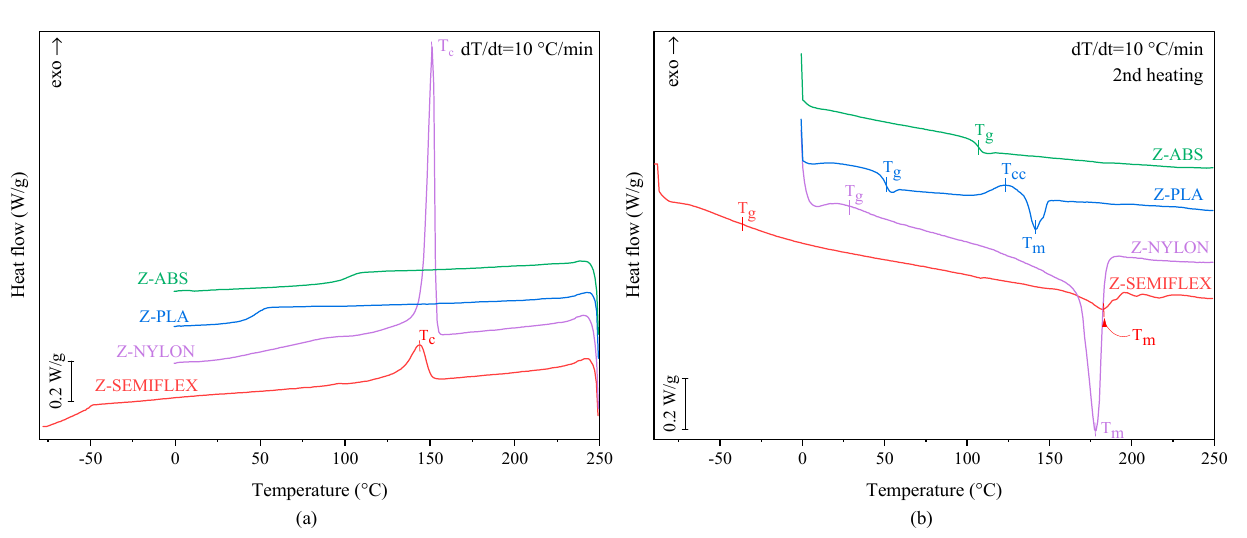
Figure 3. DSC thermograms recorded during ( a ) cooling and ( b ) second heating scans of Z-ABS, Z-PLA, Z-NYLON and Z-SEMIFLEX. Table 4. Thermal properties of investigated samples.